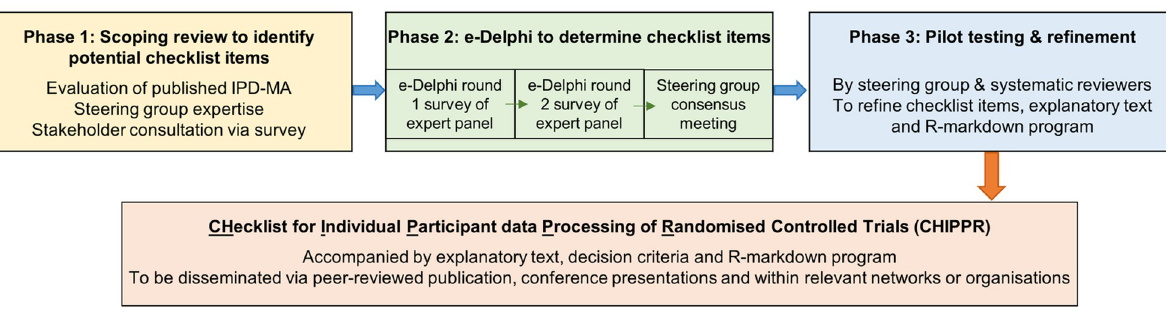
Fig 2. Overview of project